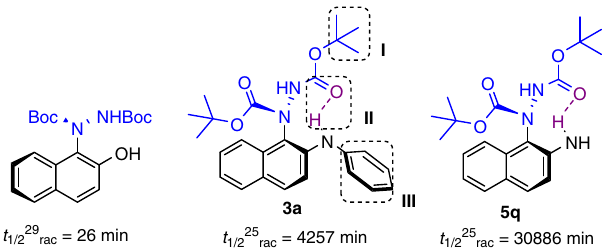
Fig. 4 The Stereo-stability study. The half-lives of racemization of 3a and 5q were examined in n -hexane at 25